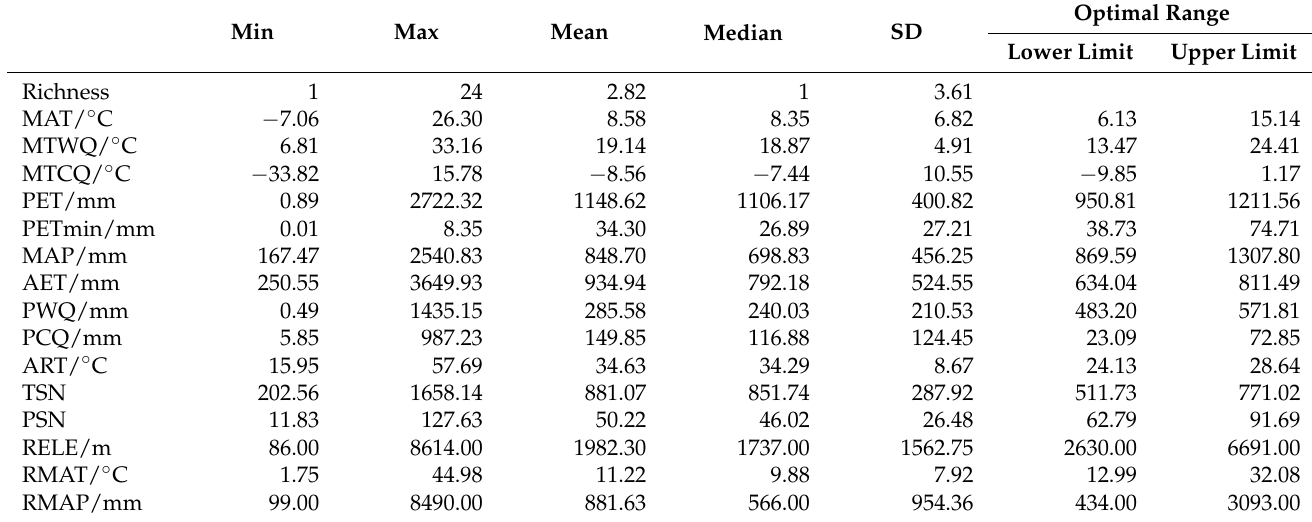
Table 2. Descriptive statistics of species richness and environmental factors in the subgenus Cerasus .